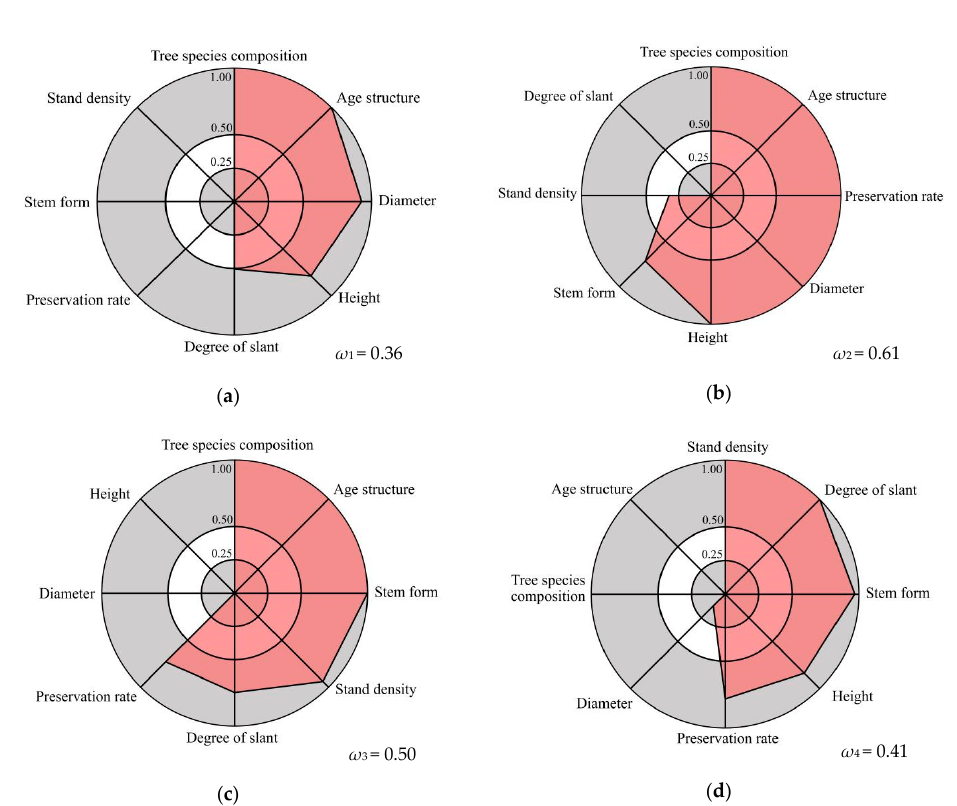
Figure 8. Stand-state unit circles of pure and mixed- Eucalyptus forests of different tree species. ω 1 is the stable state value of mixed plantation of Eucalyptus and N. cadamba (EN); ω 2 is the stable state value of mixed plantation of Eucalyptus and A. mangium (EA); ω 3 is the stable state value of mixed plantation of Eucalyptus and P. elliottii × P. caribaea (EP); and ω 4 is the stable state value of the pure forest of E. urophylla × E. grandis (EE). ( a ) Mixed plantation of Eucalyptus and N. cadamba (EN); ( b ) mixed plantation of Eucalyptus and A. mangium (EA); ( c ) mixed plantation of Eucalyptus and P. elliottii × P. caribaea (EP); ( d ) pure forest of E. urophylla × E. grandis (EE).